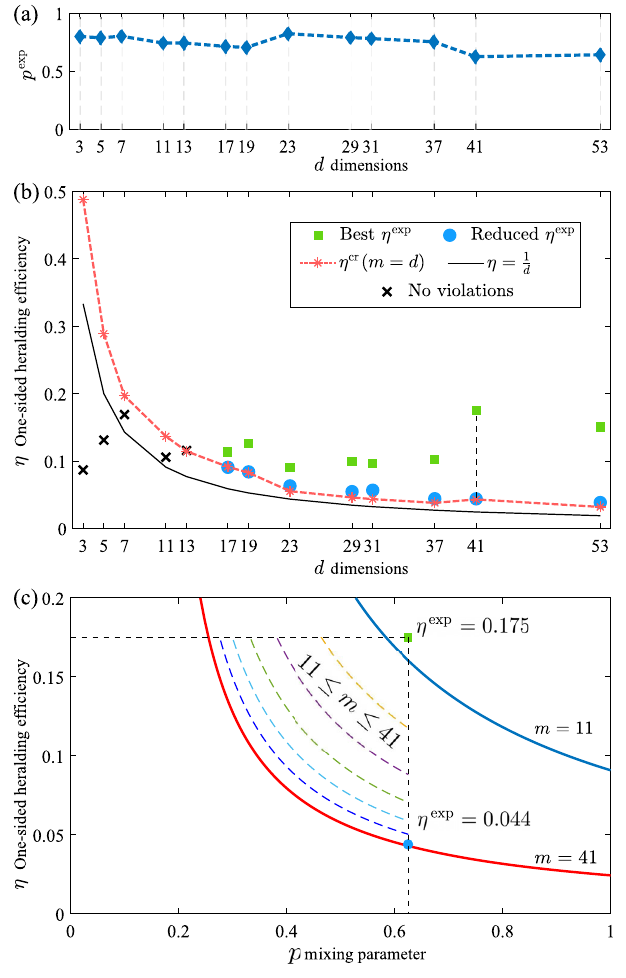
FIG. 4. Experimental results. (a) The experimental noise mix- ing parameter p exp as a function of the state dimension d corresponding to a ( 1 − p ) fraction of white noise present in the state. (b) The critical one-sided heralding efficiency required to demonstrate steering decreases as a function of d , as shown for the noise-free case ( η with p ¼ 1 , solid black curve) and nonideal state quality ( η cr with p exp < 1 , dashed red curve). In dimensions 3 ≤ d < 17 (black crosses), our experimental one-sided heralding efficiency is under the critical value [ η exp < η cr ð m ¼ d Þ ]; thus, the state does not demonstrate steering. In dimensions d ≥ 17 , we are able to demonstrate steering with similarly low heralding efficiencies η exp (green squares) by using m ¼ d MUB settings. The experimental heralding efficiency can be lowered further (blue dots) by adding loss in Alice ’ s channel, allowing us to demonstrate EPR steering in d ¼ 53 with a record low η exp ¼ 0 . 038 and a noise parameter p exp ¼ 0 . 641 . (c) To showcase the loss tolerance of our binarized steering inequality, we focus on the case at d ¼ 41 . At η exp ¼ 0 . 175 , one can demonstrate steering with fewer measurement settings ( m ¼ 11 ). However, when Alice ’ s channel efficiency is reduced by a factor of 4 to η exp ¼ 0 . 044 , EPR steering can still be demonstrated by using more measurement settings ( m ¼ 41 ).